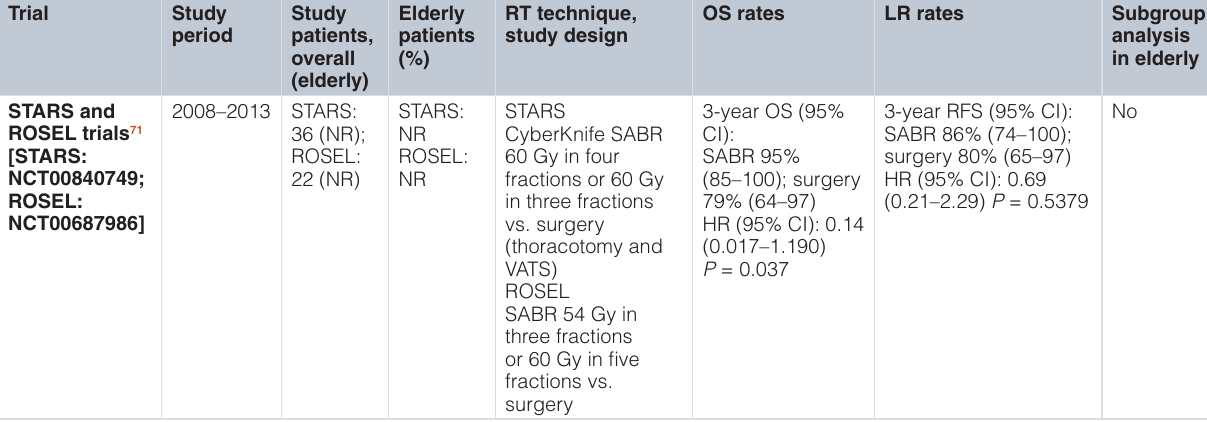
Table 5. Stereotactic ablative radiotherapy versus lobectomy for operable stage I non-small cell lung cancer: two randomized trials. Trial